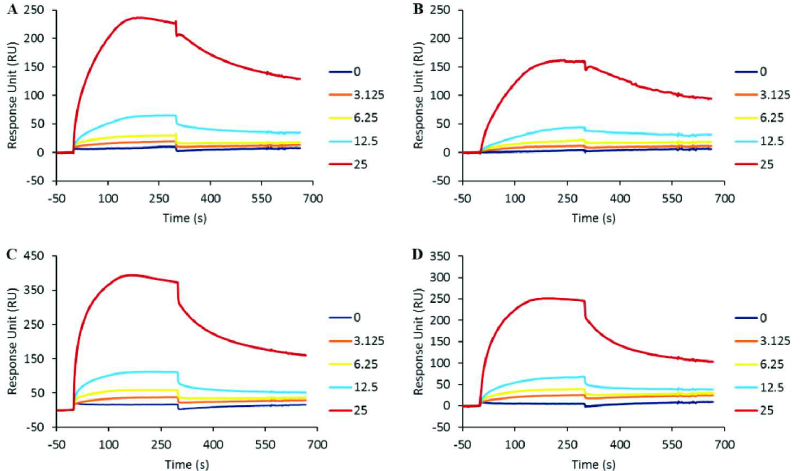
Fig 2. IND02 and IND02-trimer binding to gp120 immobilized sensorchip. IND02 (A and B) and IND02-trimer (C and D) at the indicatedconcentrations (in μ M) was injected at 25 μ l/min for 5 minutes over the immobilized gp120, and the specific bindingresponse in resonance unit (RU) was recorded as a function of time (S). Overlay of the sensorgrams is depicted for IND02 and IND02-trimer over MN- (A and C) and YU2- gp120 (B and D) respectively. After each injection,the surface was regenerated by a short pulse of 10 mM NaOH.